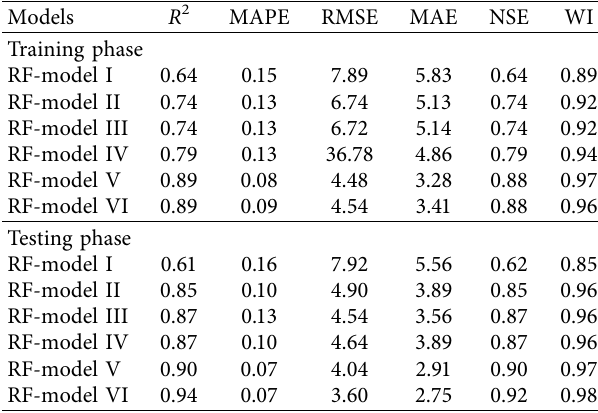
Table 9: Statistical measurements for DLNN model over training and testing phase for all input combinations.